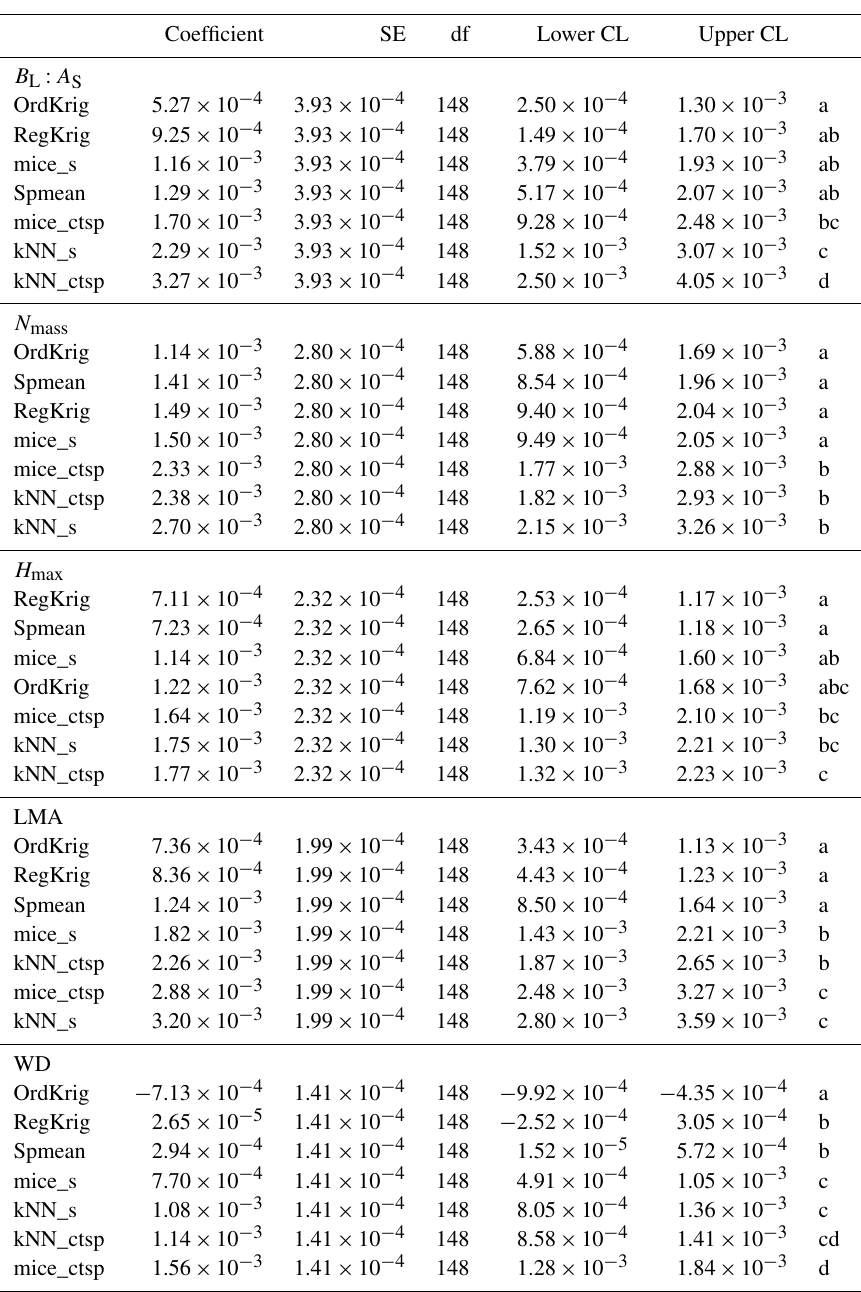
Table 1. Tukey pairwise comparisons of the LME model coefficients (and 95% lower and upper confidence limits) relating trait-specific KGE (higher values of KGE imply higher performance) to increasing missingness levels for different imputation methods: species mean (Spmean); mice and kNN with species as predictor (mice_s and kNN_s, respectively); mice and kNN with species, climate, forest structure and spatial variables as predictors (mice_ctsp and kNN_ctsp, respectively); ordinary kriging (OrdKrig); and regression kriging (RegKrig). Traits: leaf biomass to sapwood area ratio, B L : A S (tm − 2 ); leaf nitrogen per unit mass, N mass (%mass); maximum tree height, H max (m); leaf mass per area LMA (mgcm − 2 ); wood density, WD (gmcm − 3 ). Different letters, in alphabetical order following the increasing order of the model coefficient, denote significant differences ( P < 0.05) in the results of multiple